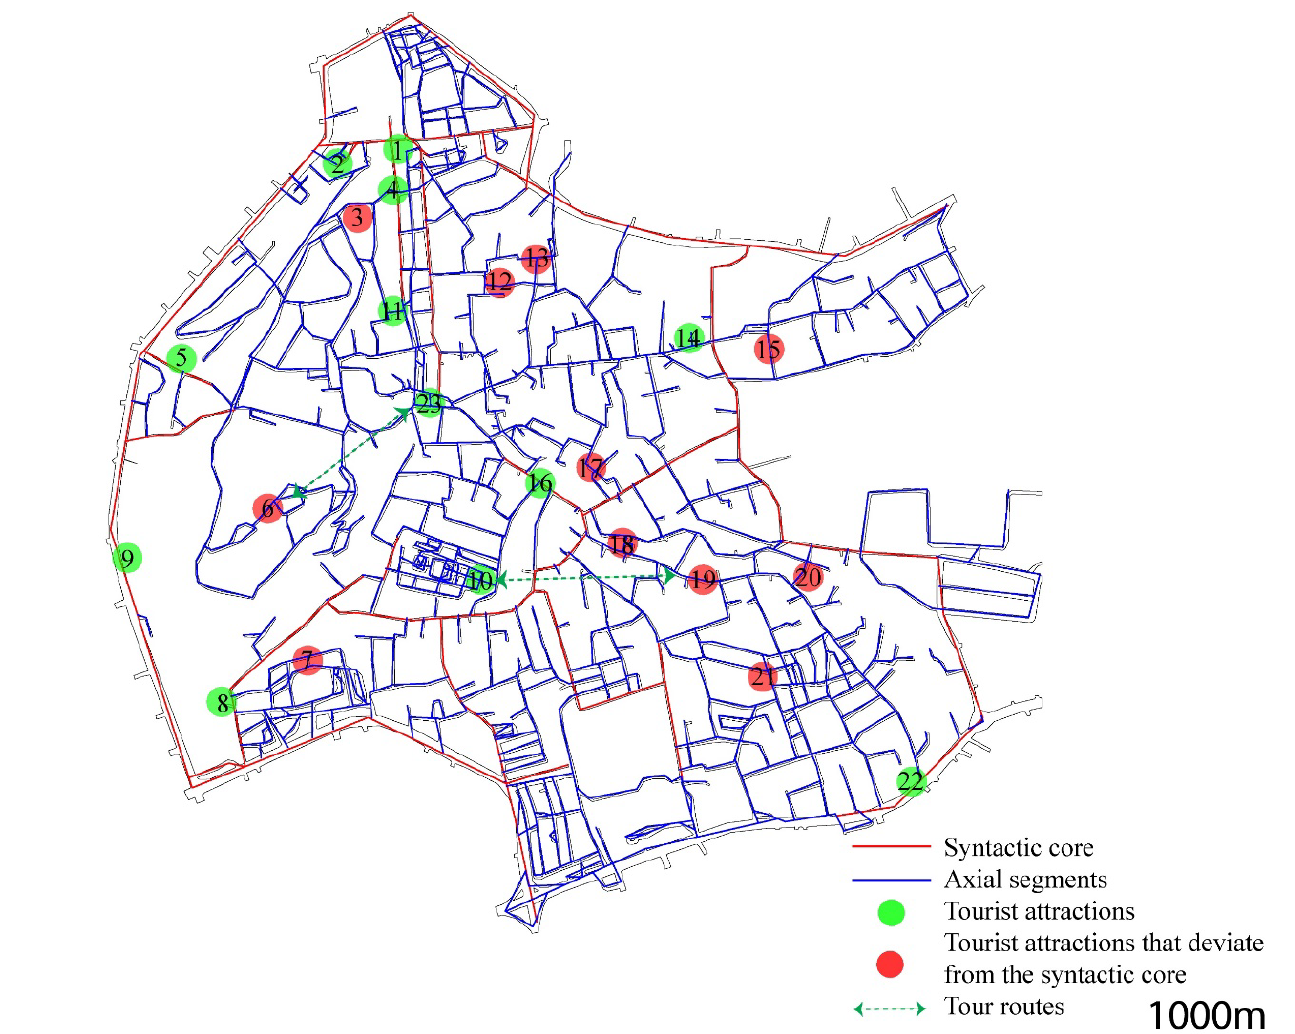
Figure A1. The POI tourist attraction distribution in Pingyao. The red colour indicates that tourist attractions deviate from the syntactic core of the town.